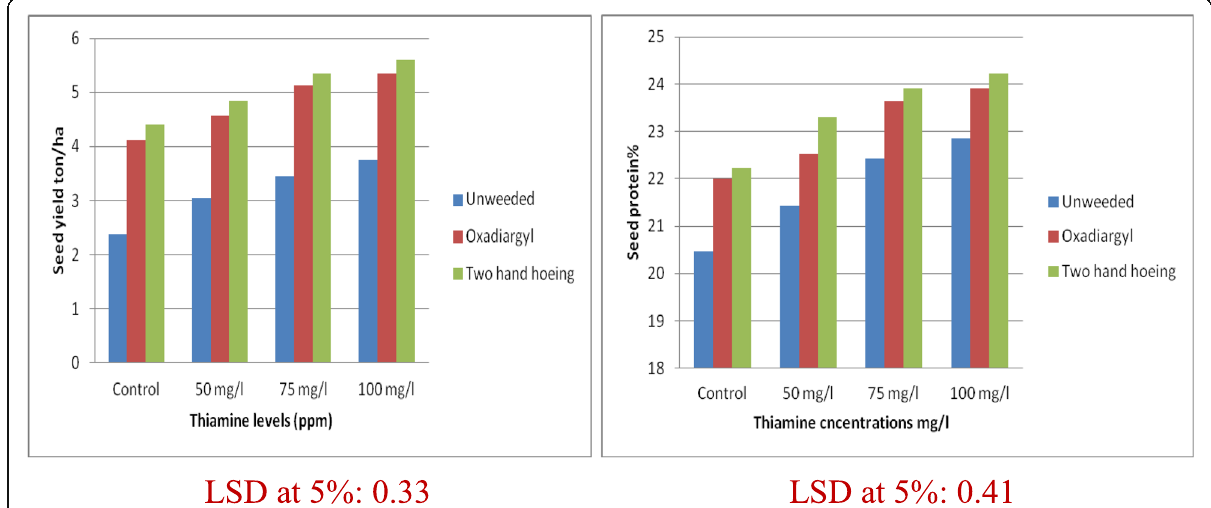
Fig. 8 Effect of the interaction between thiamine levels and weed control on seed yield ton/ha and seed protein percentages (combined analysis of two